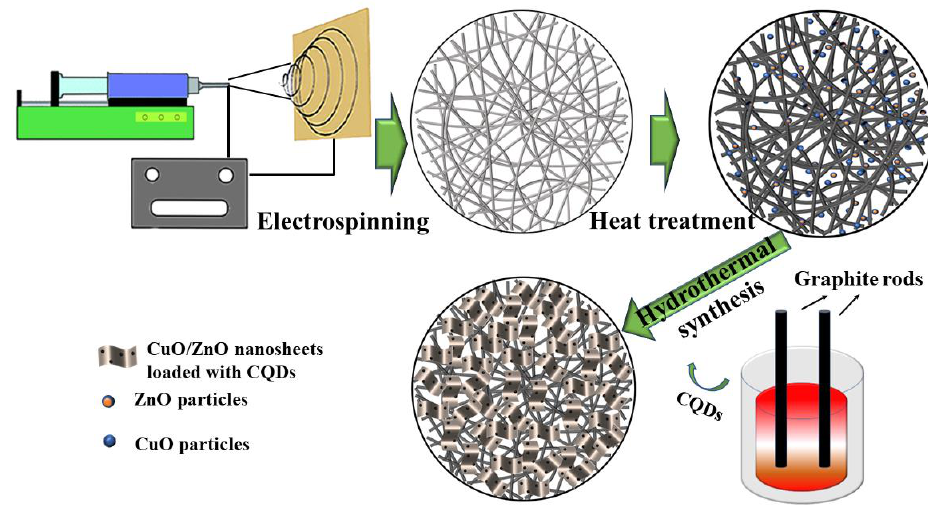
Figure 5. Preparation flowchart of